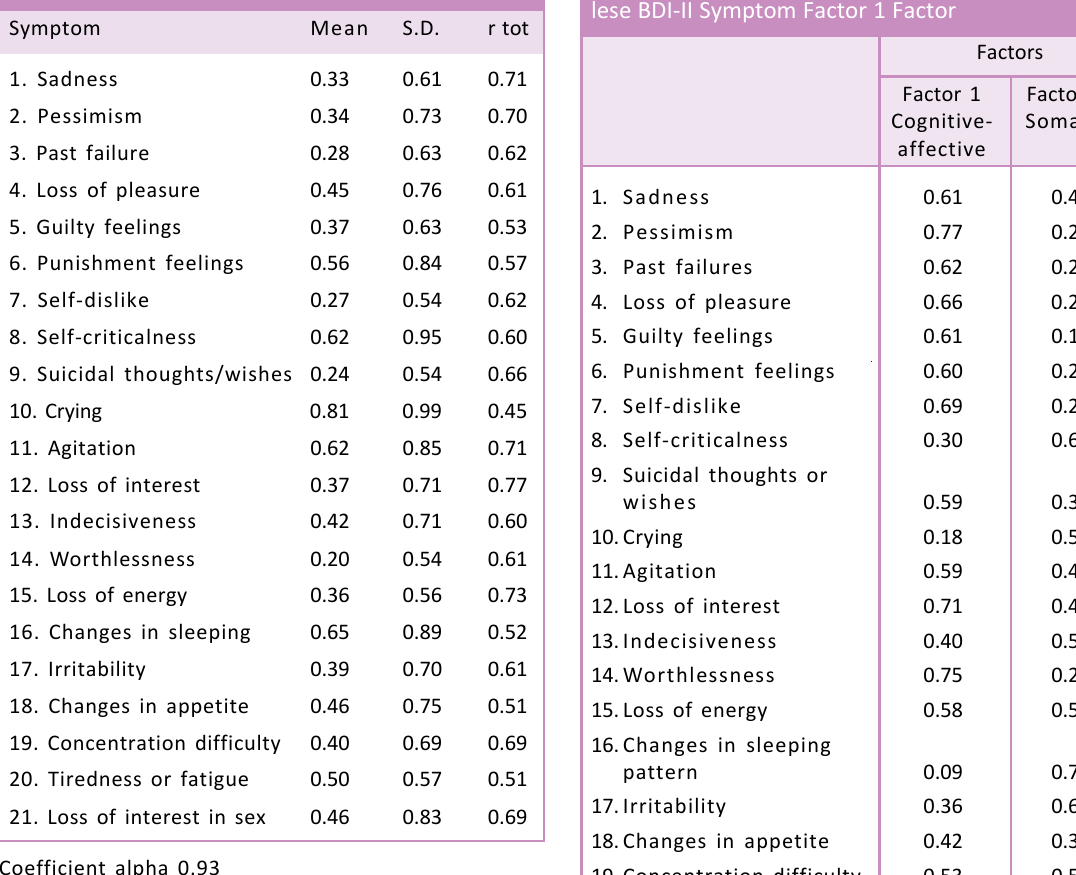
Table 2. Promax-rotated iterated-principal-factor standardized regression coefficients of the